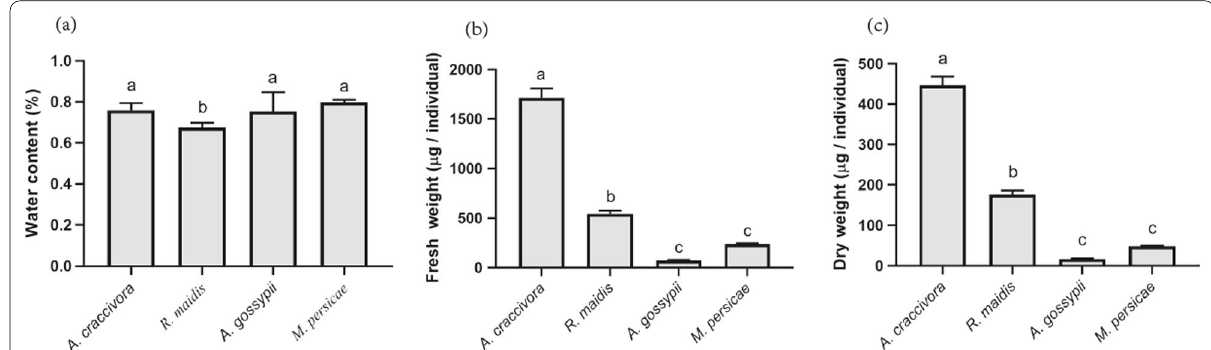
Fig. 3 Water content ( a ), fresh ( b ) and dry ( c ) body weights of four aphid species. Values are mean followed by LSD test with α 0.05, and means indicated by the same letter are not significantly different =